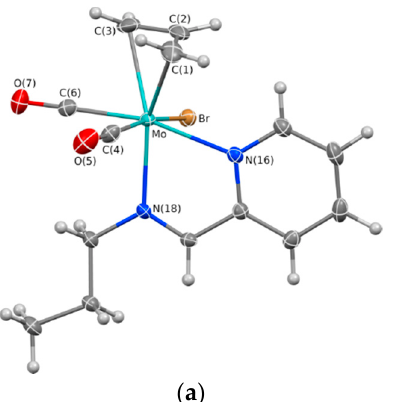
Figure 1. Molecular structures of the isomers found in the crystal structure of [Mo( η 3 -C 3 H 5 )Br(CO) 2 (IMP)] ( 1 ) with the thermal ellipsoids drawn at the 50% probability level: ( a ) axial-exo; ( b ) equatorial-exo.